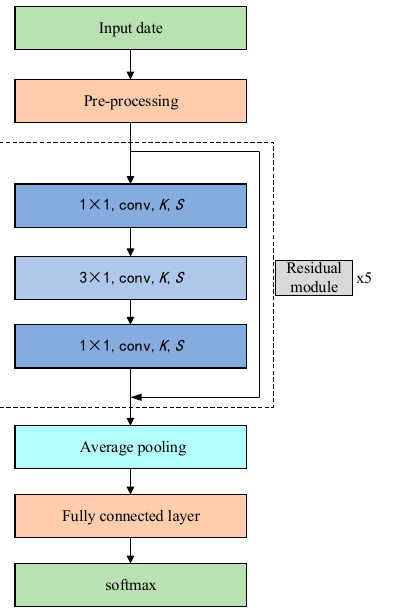
Figure 4. Example of a residual module.